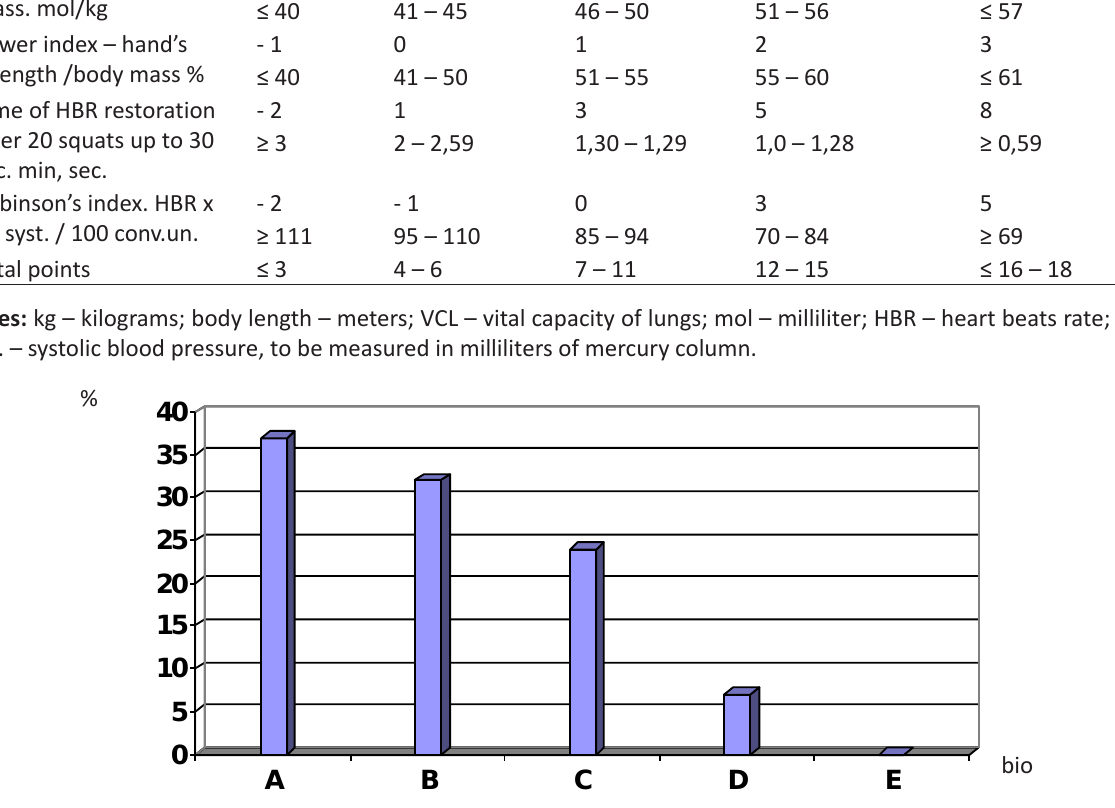
Fig. 4. Distribution f physical health level in percents (%) of 41 Kharkov national medical university girl students: A -low; B – below average; C - average; D – above average; E – high;; Bio – biological level of